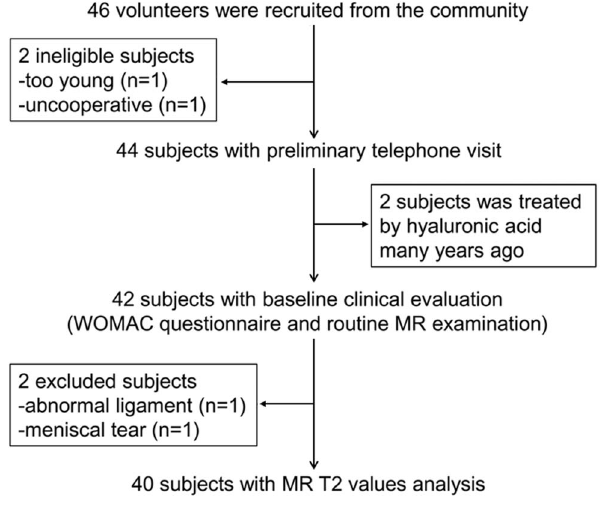
Figure 1. Flowchart shows the process used to select and recruit subjects from the local